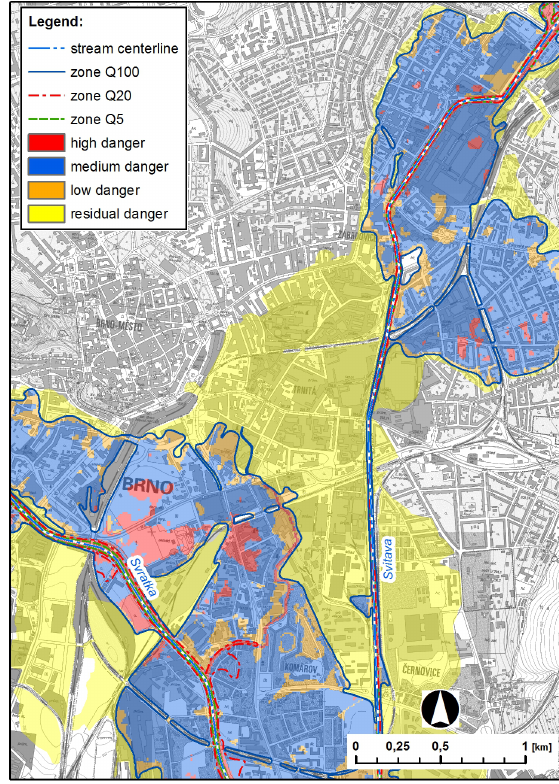
Fig. 7. Example of a flood risk map for the rivers Svratka and Svi- tava in Brno – areas with exceeded acceptable risk (original scale 1:10000) (BCM,